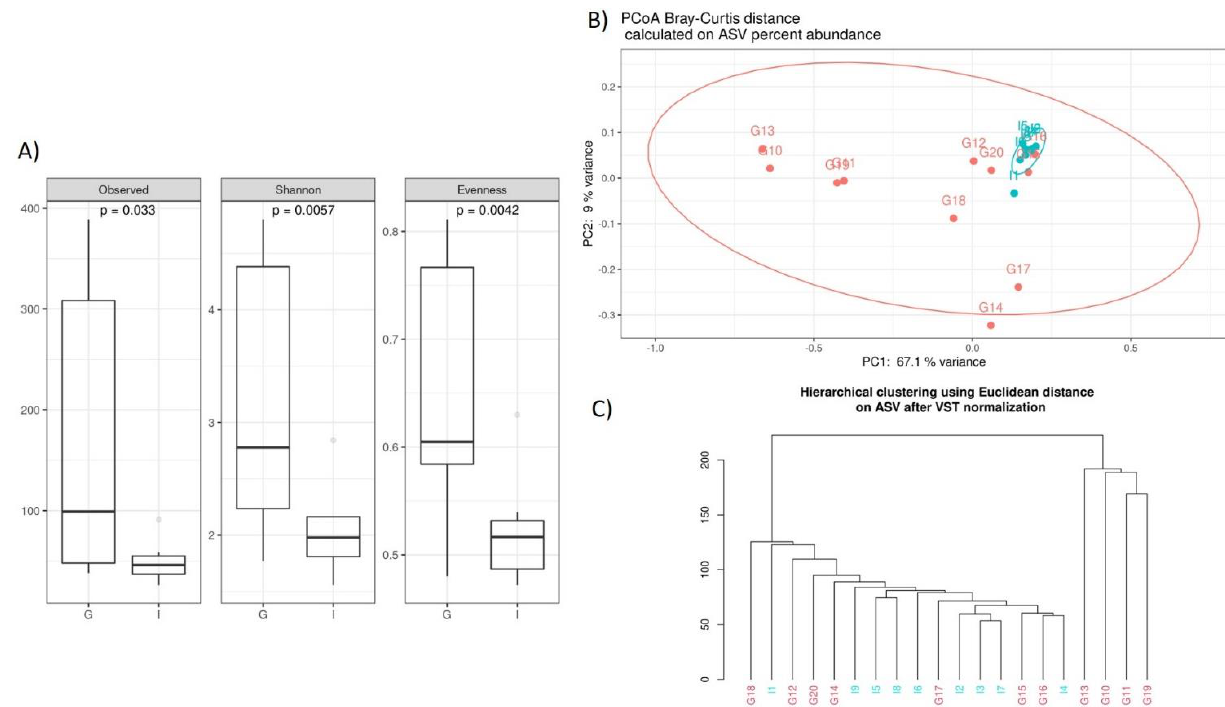
FIGURE 2: Box- plots (A) showing alpha diversity indices (Observed ASV richness, Shannon index, Pielou’s Evenness) in German (G) and Italian (I) patients. Statistical differences were assessed using Mann-Whitney test and p-values less than 0.05 were considered statistically significant. Principal Coordinate Analysis (B) and Hierarchical clustering (C) of Italian (I) and German (G) CAV